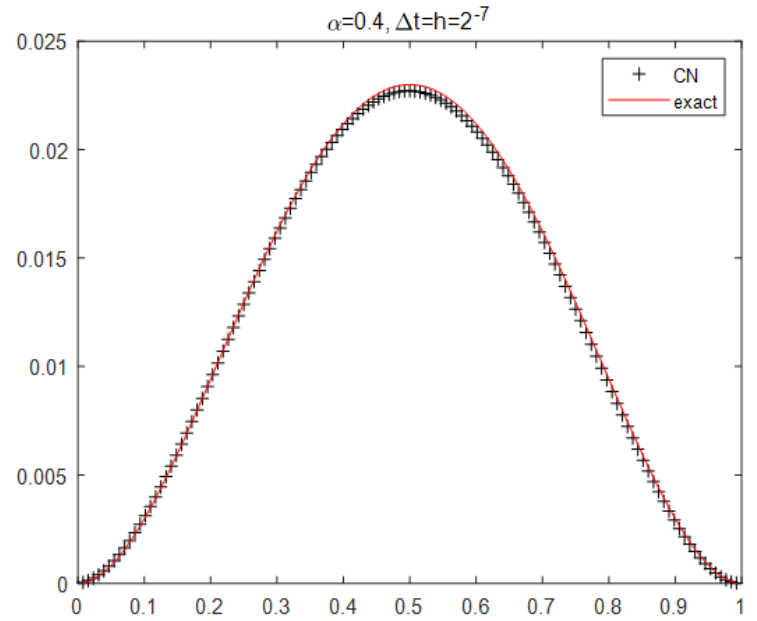
Figure 6. The numerical solution for the Crank-Nicolson scheme and exact solution for Example 2 with α = 0.4, ∆ t = h = 2 − 7 at time T = 1.